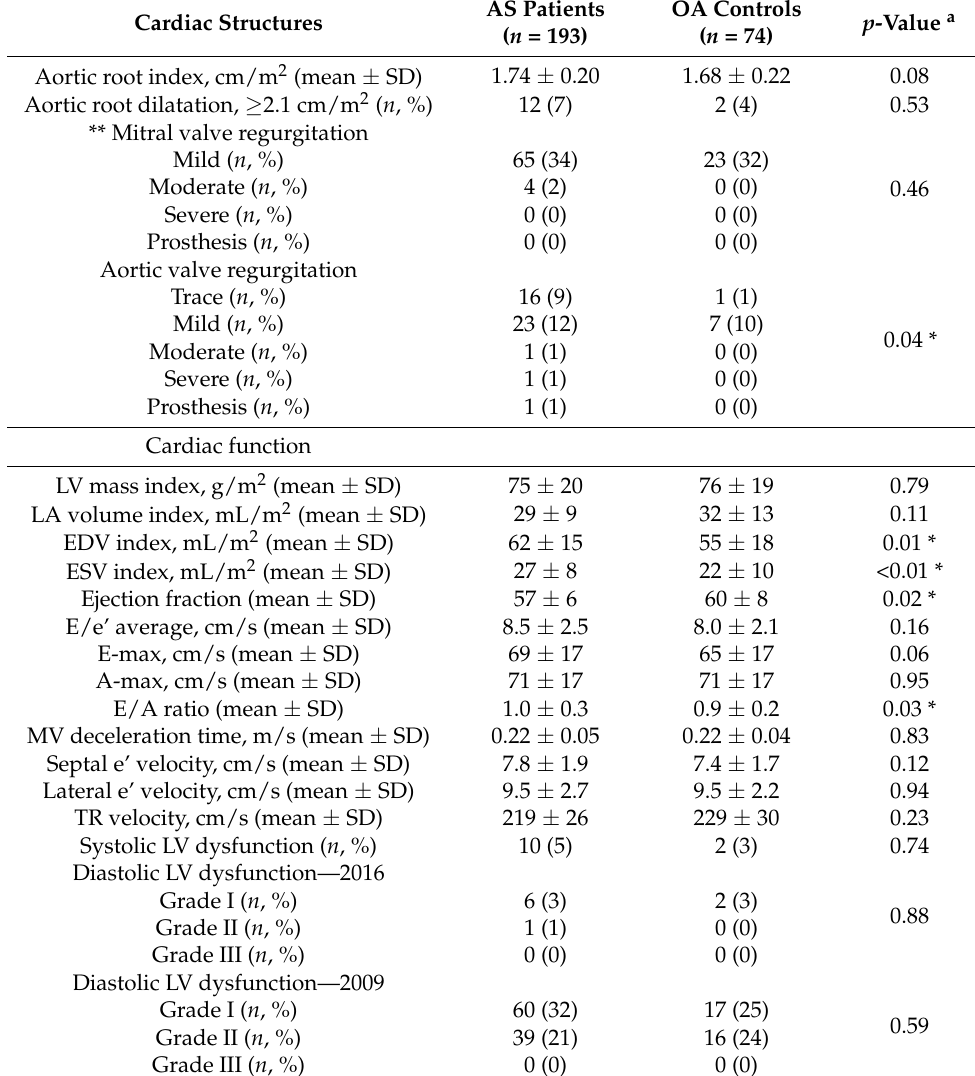
Table 4. Echocardiographic results. Cardiac